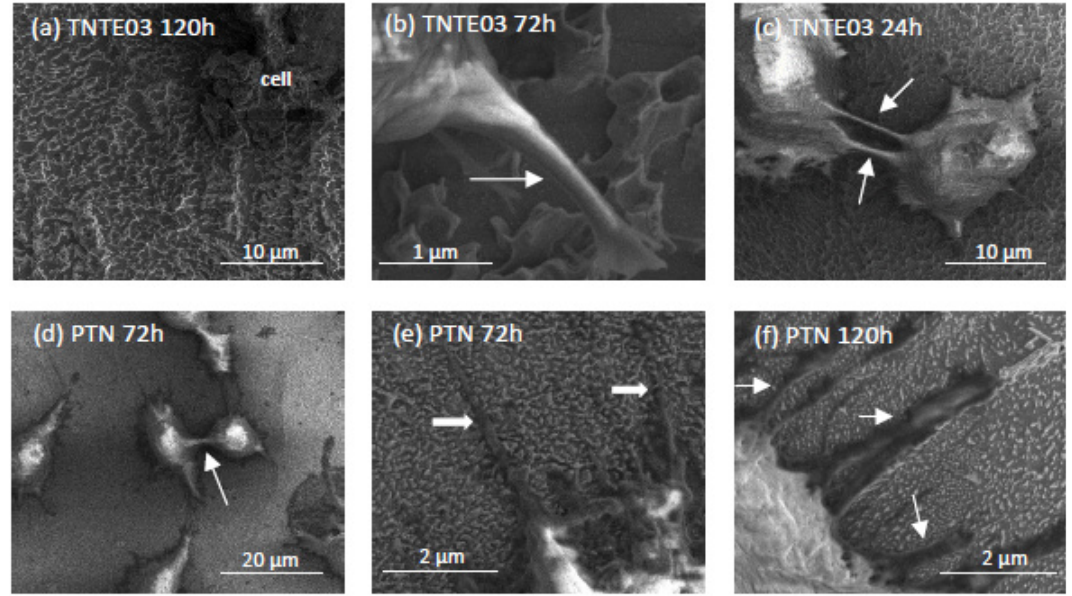
Figure 8. Scanning electron microscopy (SEM) images showing the murine L929 fibroblasts adhesion (after 24 h) and proliferation (after 72 h or 120 h) on the surfaces of the tested nanocoatings: Ti6Al4V alloy references sample, porous titania nanocoating (PTN), titania nanoteeth (TNTE03), and titania nanotube coating (TNT30). The white arrows in the figure indicate the filopodia spread between fibroblasts ( c , d ) and filopodia, which attached the cells to the nanomaterial surface ( b , e , f ). In Figure ( a ) there are the cells that morphologically resemble the structure of the TNTE03, which makes it difficult to recognize them on the surface under greater magnification (see TNTE03 120 h; scale 100 µ